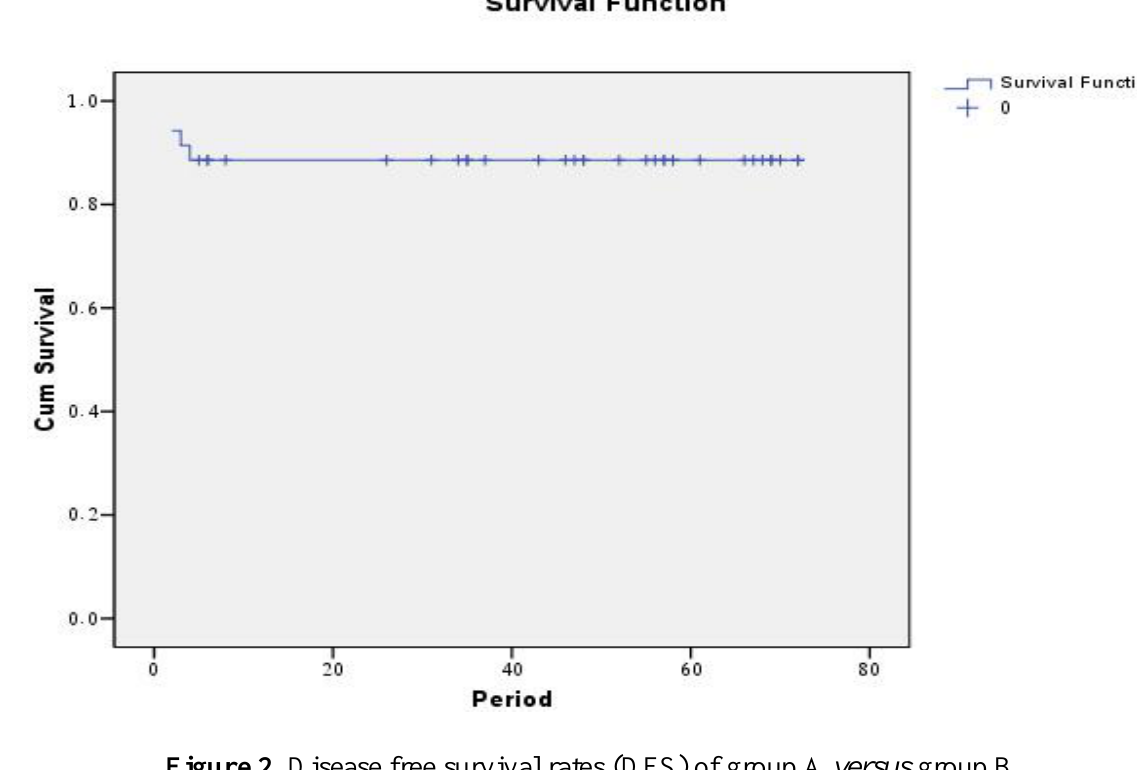
Figure 1. Disease free survival rates (DFS) for all patients.